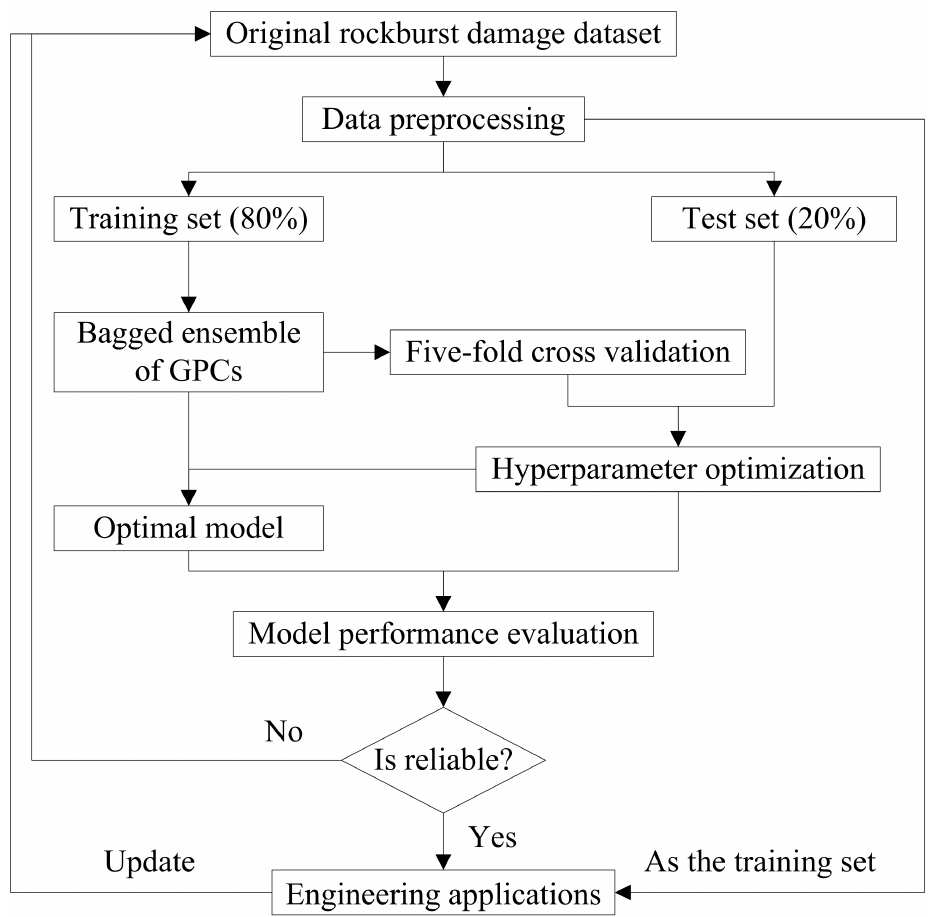
Figure 4. The procedure of the ensemble model for the evaluation of rockburst